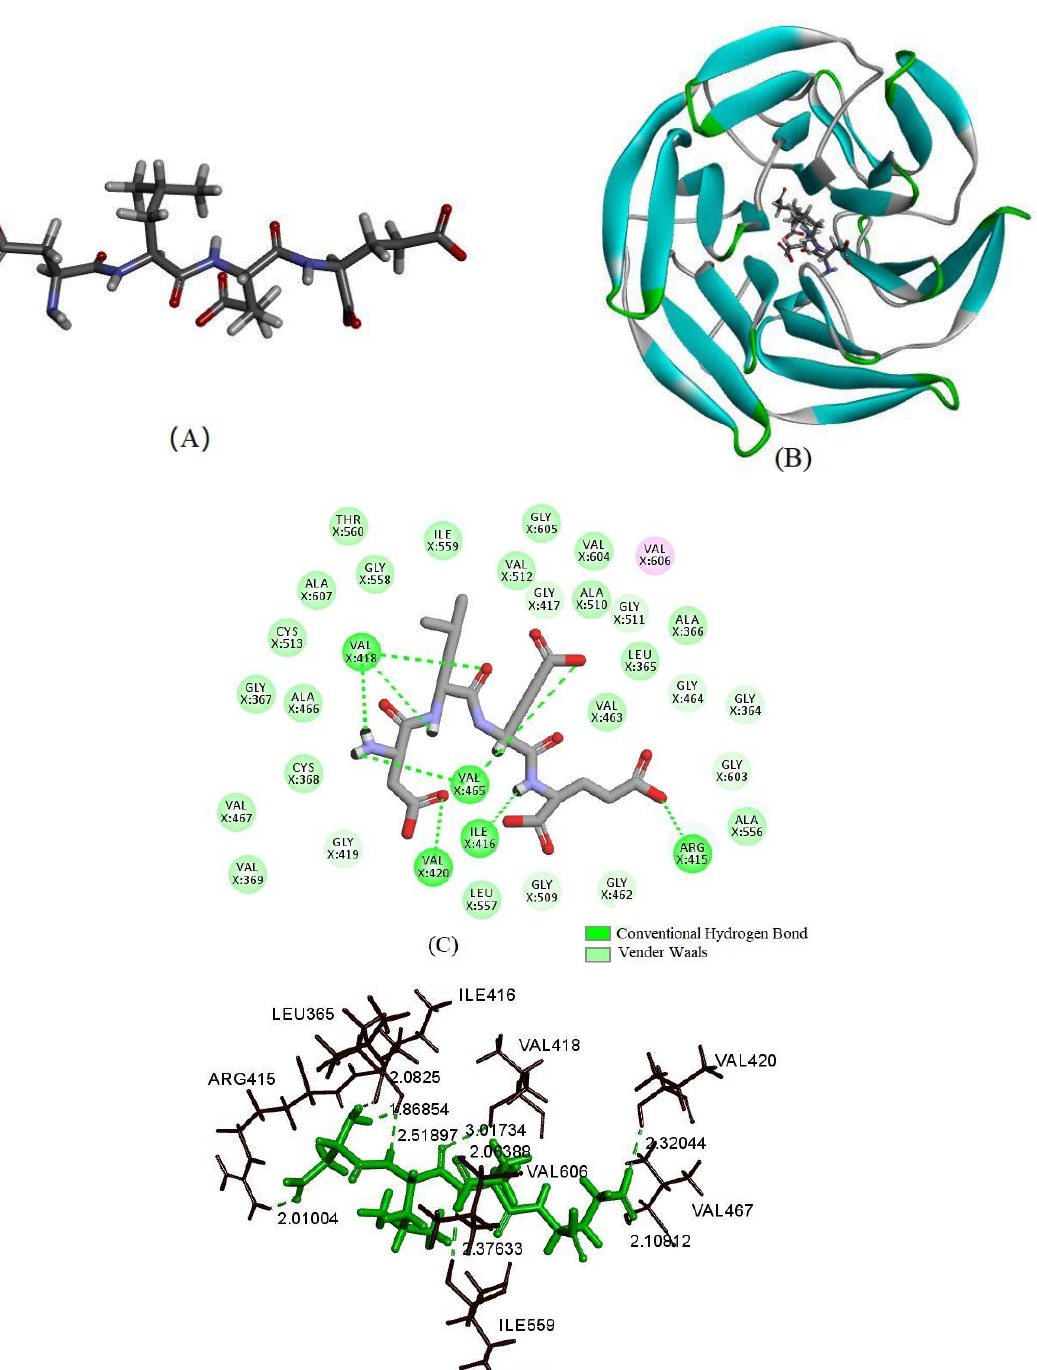
Figure 6. The molecular docking of DLEE peptides with Keap1 protein. ( A ) The small-molecule ligand of DLEE. ( B ) The optimal docking pose of DLEE with the Kelch domain of human Keap1 protein (PDB: 2FLU). ( C ) A 2D diagram of DLEE and Keap1 amino-acid residues. ( D ) An H-bond interaction diagram of DLEE and Keap1 amino-acid residues.